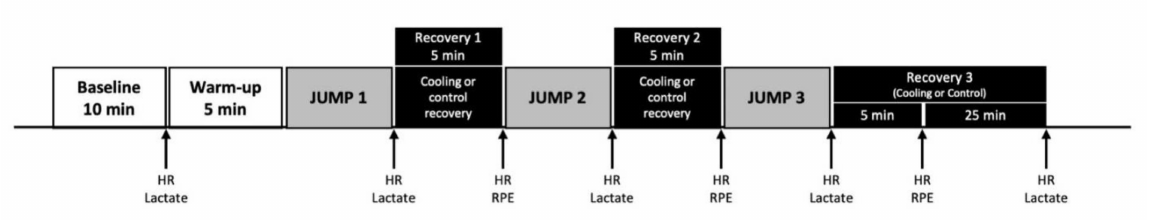
Figure 1. Schematic representation of the experimental protocol. JUMPs 1–3, sets of the vertical jump exercise; HR, heart rate; Lactate, blood lactate; RPE, rate of perceived exertion. During Recoveries 1 and 2, subjects rested with or without the cooling suit in a randomized order. Due to time spent for putting the cooling suit on the test subjects, actual cooling time in Recoveries 1 and 2 was 3 min. Recovery 3 lasted 30 min with or without the cooling